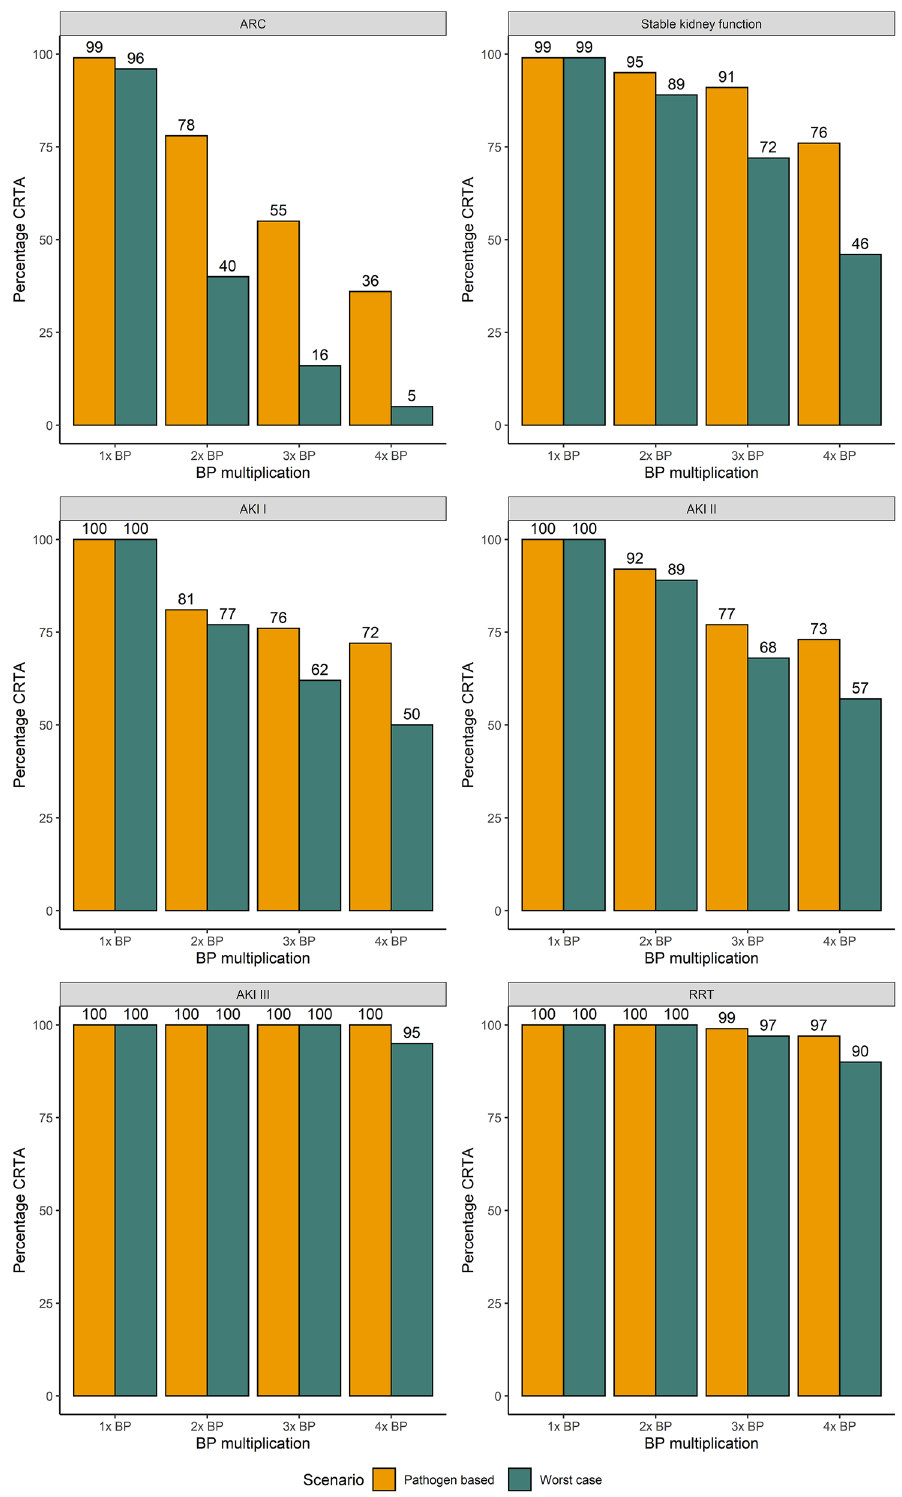
Fig. 3 Percentage of CRTA for all TZP samples according to renal function and BP multiplication